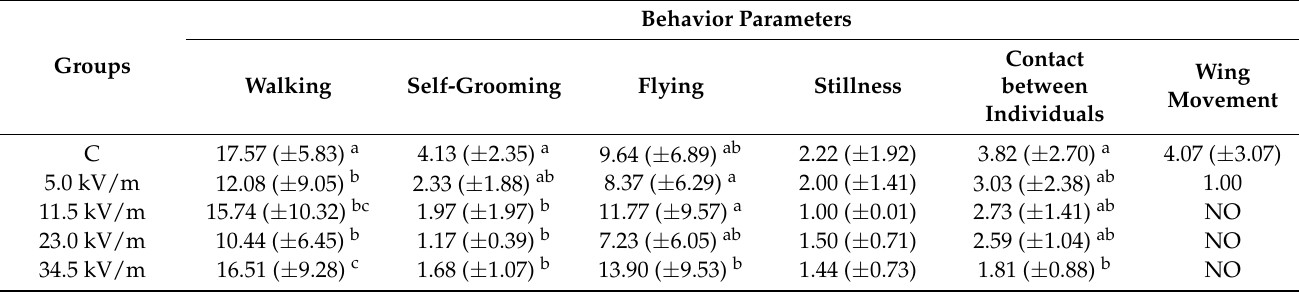
Table 2. Comparison of the number of behavior occurrences between all groups.